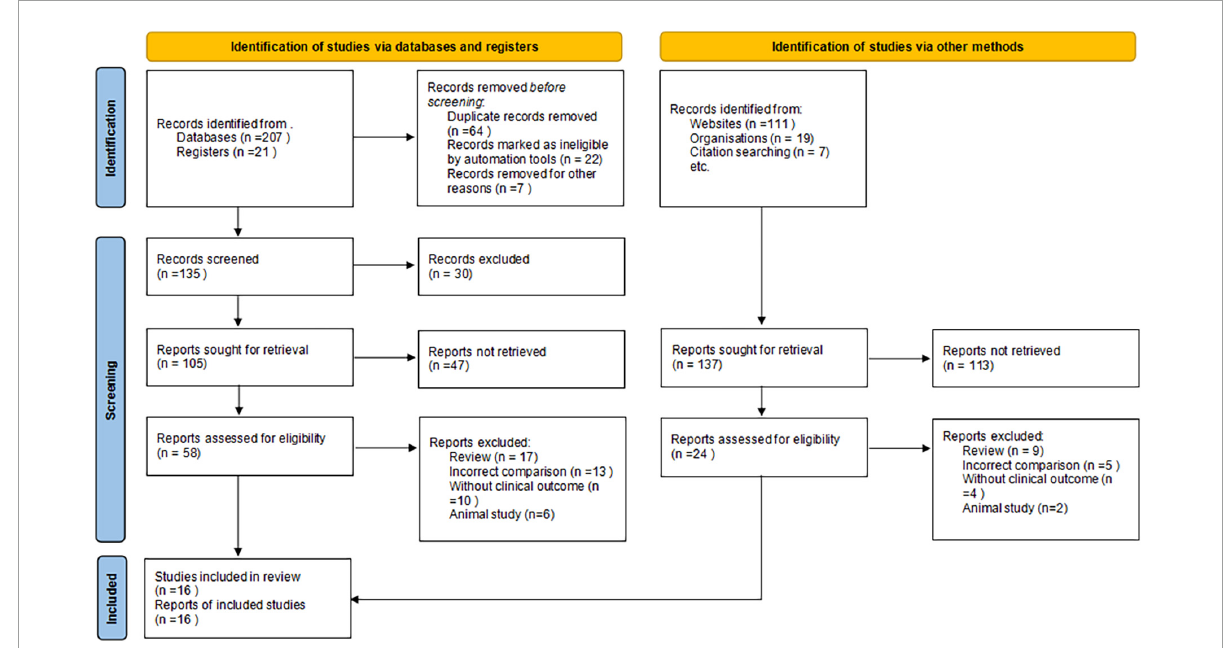
FIGURE1 Flow chart of study